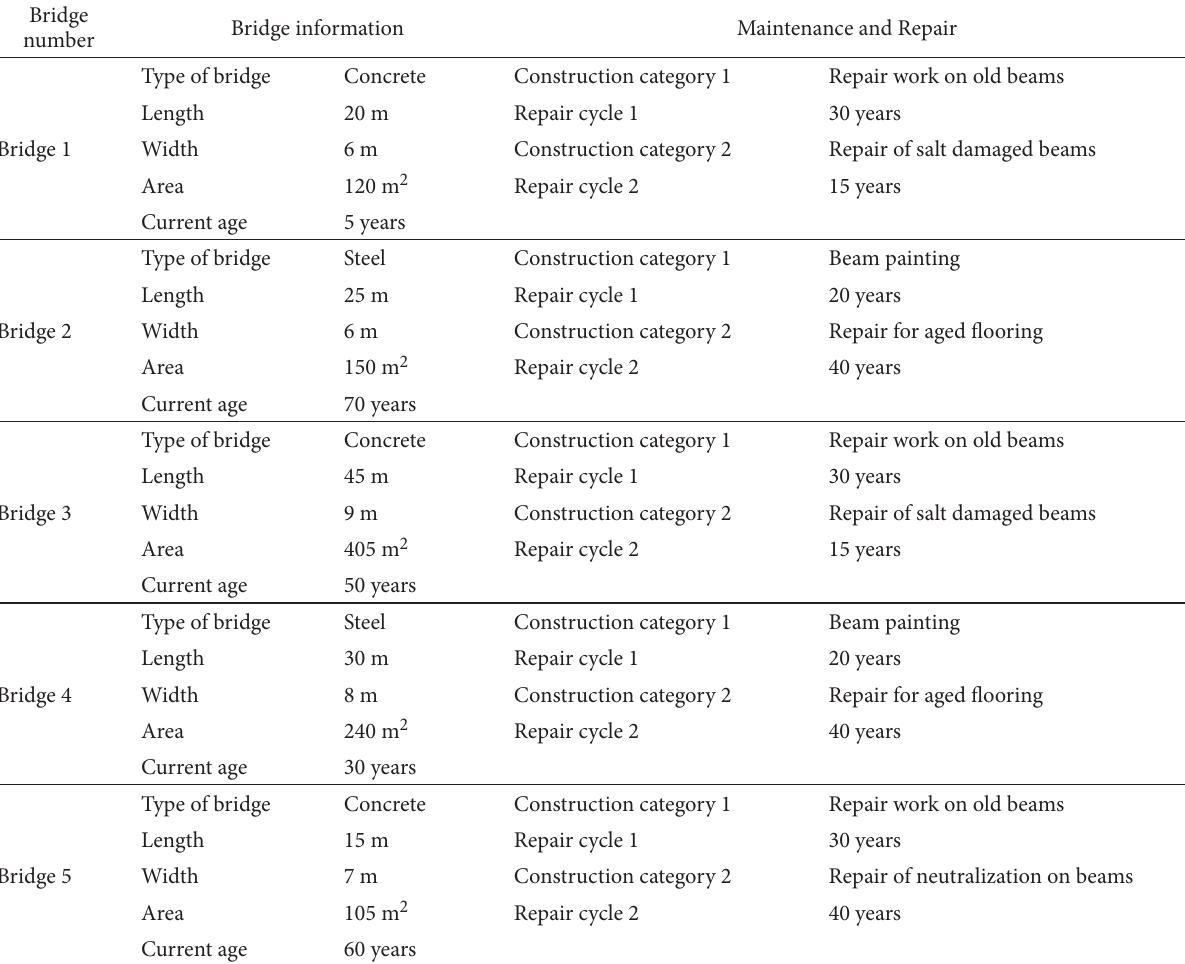
Table 2. Tentative bridge information (example: Bridges